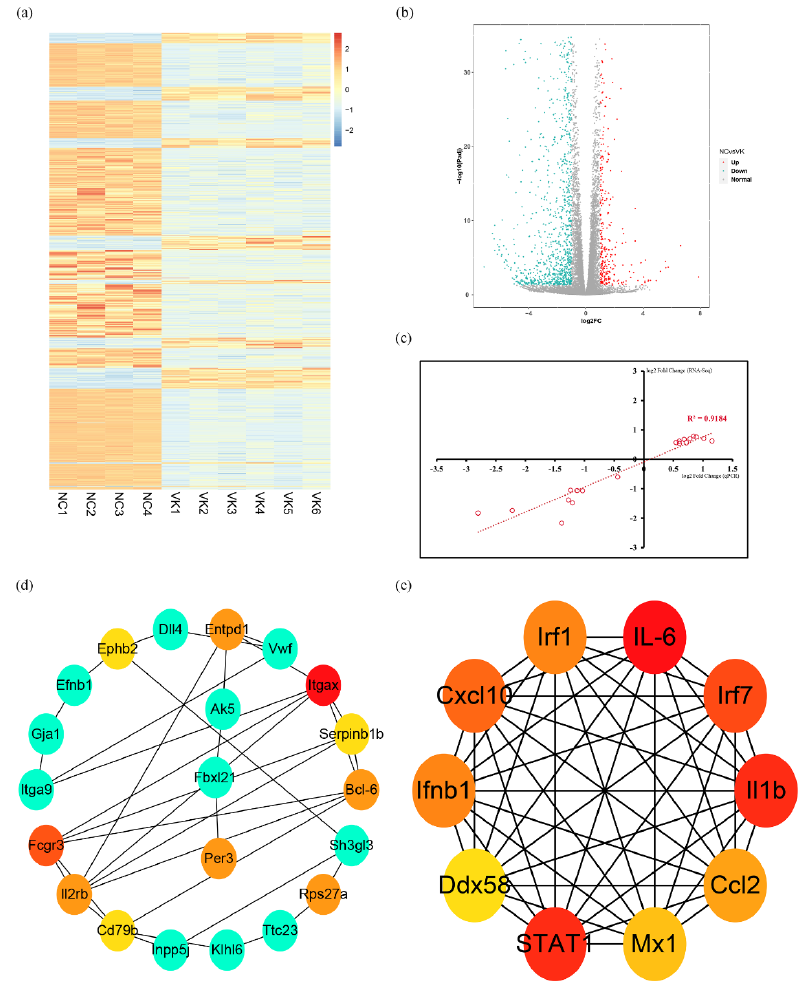
Figure 3. DEGs profiling by RNA-seq. ( a ) Heatmap of RNA-seq. ( b ) Volcano plots of RNA-seq. ( c ) Reliability verification of RNA-seq data. ( d ) Up-top 10 in network string–string interactions ranked by Degree method. ( e ) Down-top 10 in network string–string interactions ranked by Degree